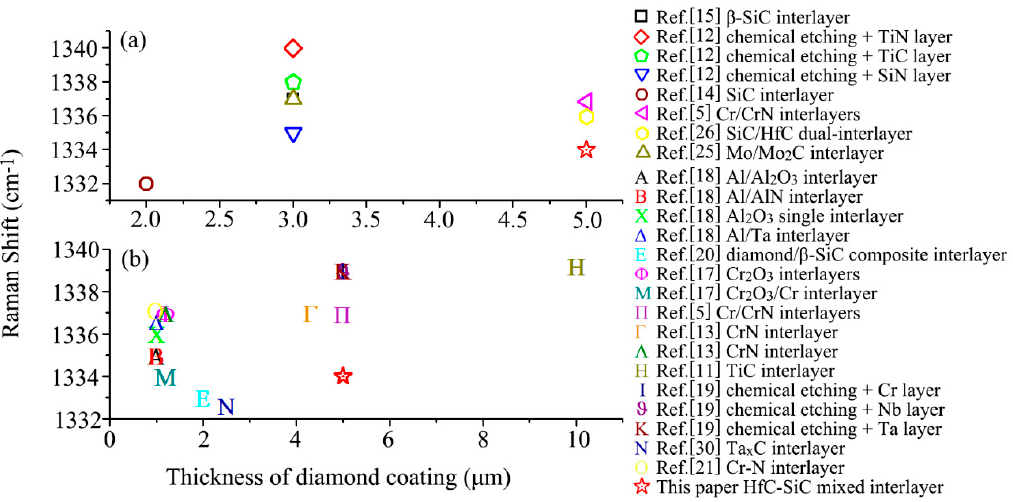
Figure 10. Raman shift of ( a ) nano- and ( b ) micro-diamond coatings deposited on WC-Co substrates with different interlayers.